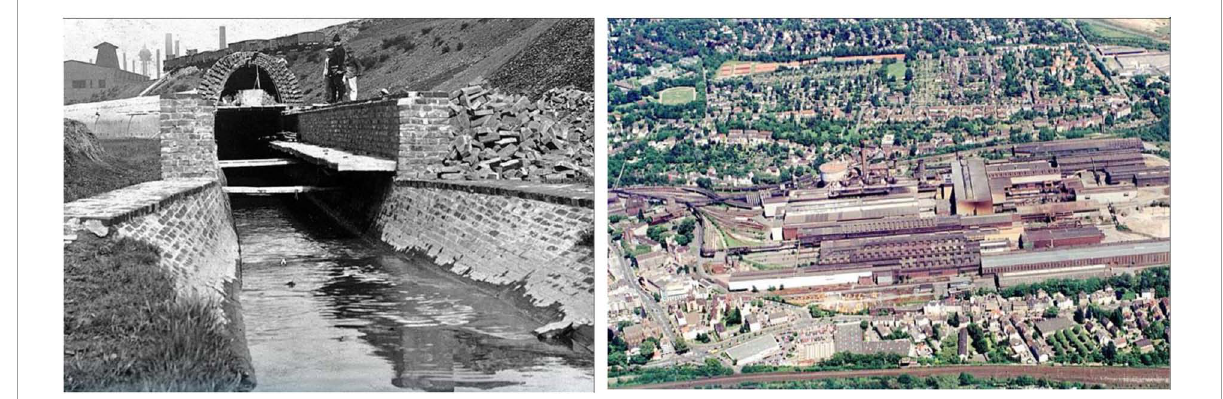
FIGURE5 Former underground Hoesch Kanal for buried Emscher (left) and buried Hörder stream underneath Hermannshütte steelplant (right).